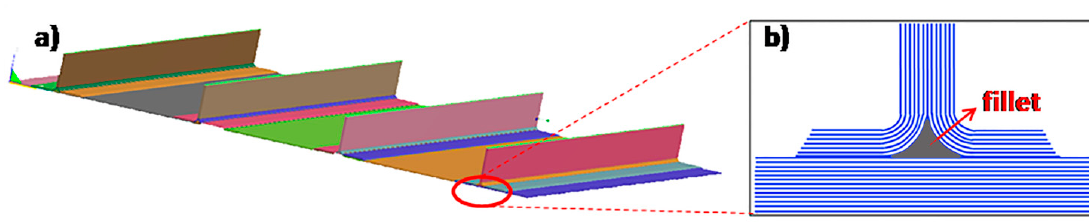
Figure 1. ( a ) Stiffened panel; ( b ) front view of the bottom of the stringer in contact with the flat laminate.